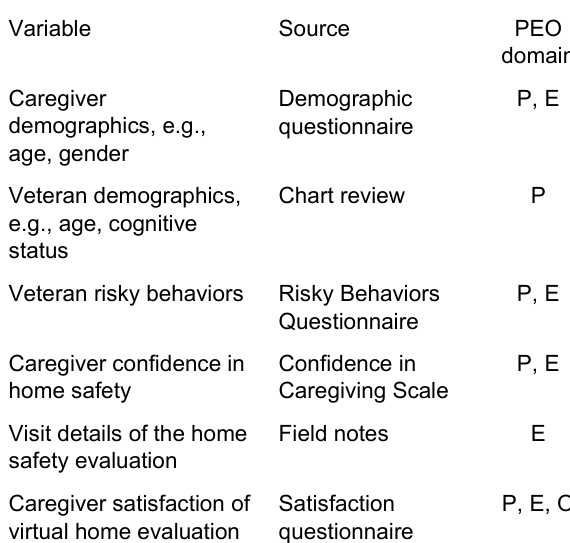
Summary of Variables by PEO